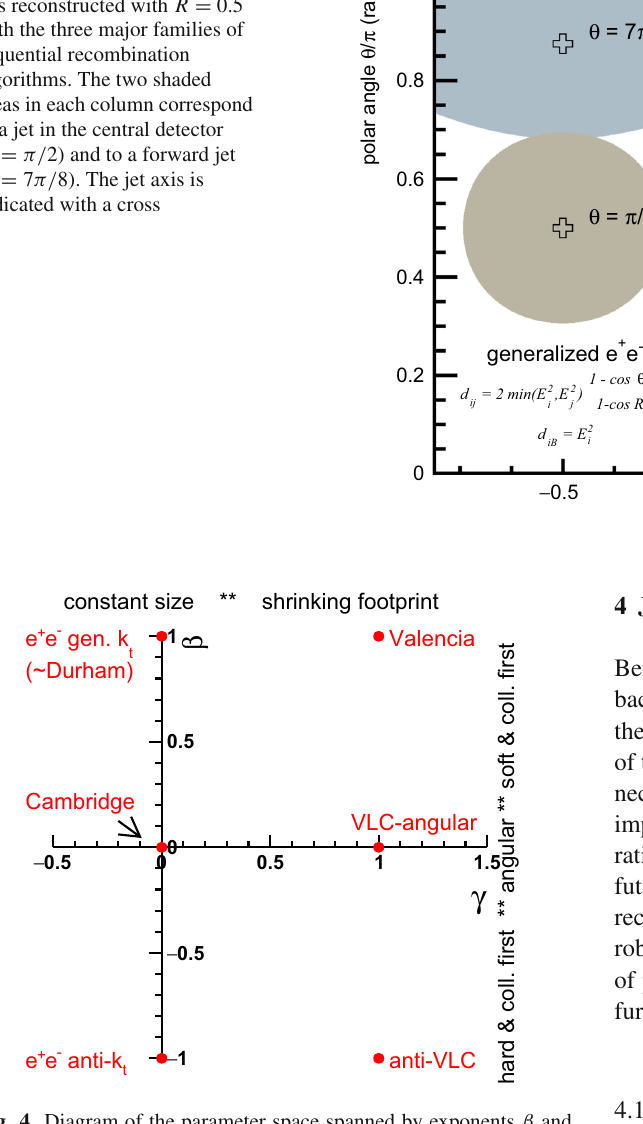
slower decrease of the area when the polar angle goes to 0 or π